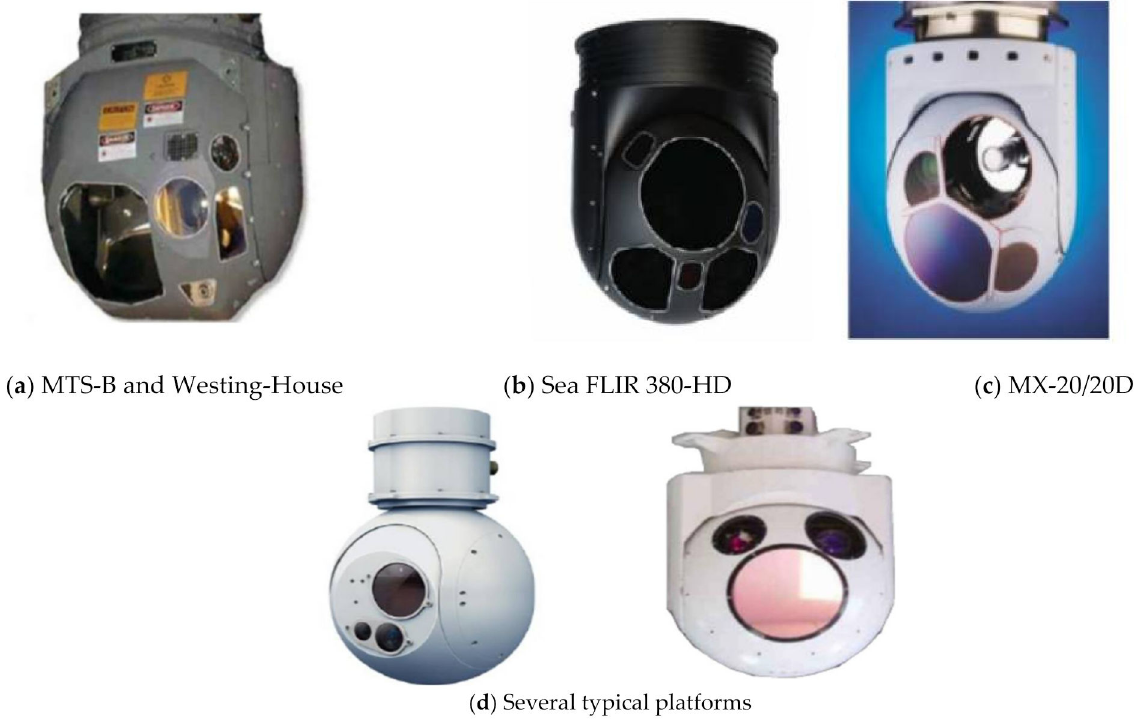
Figure 1. Airborne aviation photoelectric stabilization